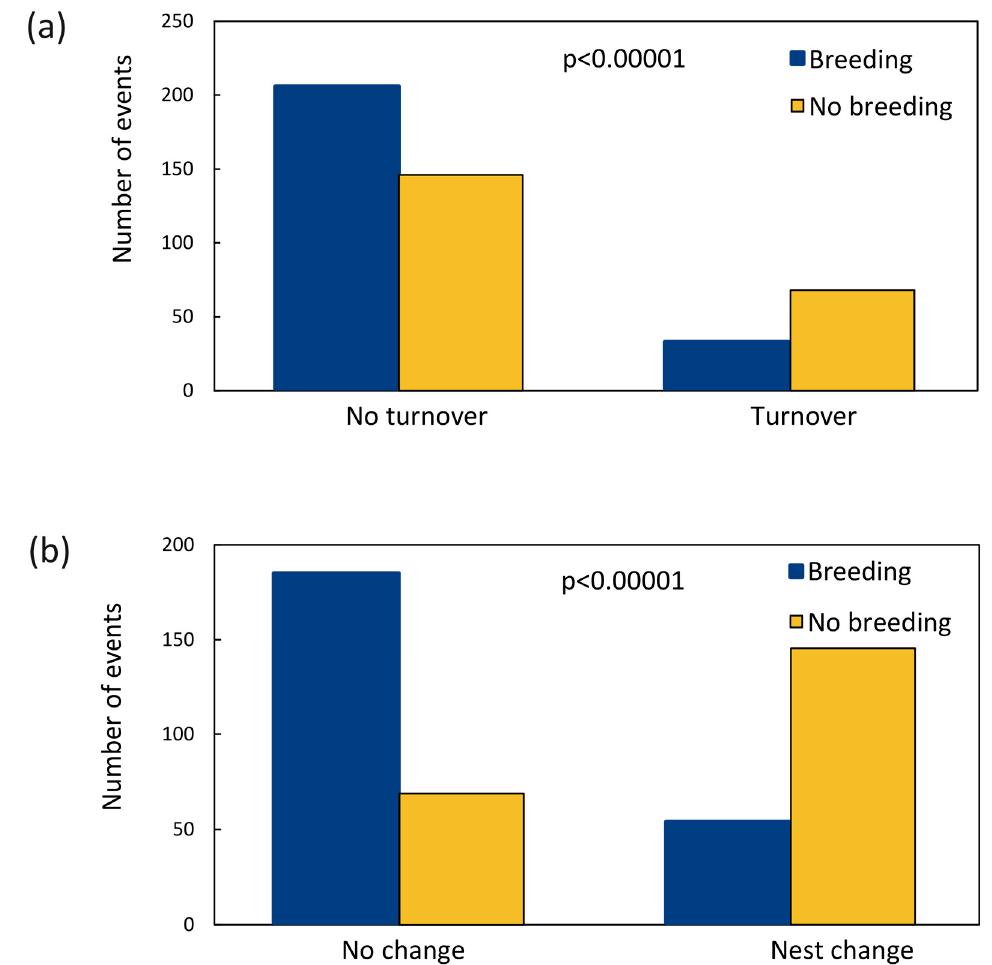
Figure 4. ( a ) Number of breeding events with and without turnover following successful (blue bars; breeding) and unsuccessful (yellow bars; no breeding) breeding a tt empts in the previous year. ( b ) Number of nest site changes within a territory when there was a successful (blue bars; breeding) or an unsuccessful (yellow bars; no breeding) breeding in the previous year, and the number of occasions when the pair used the same nest after a successful or an unsuccessful breeding year.